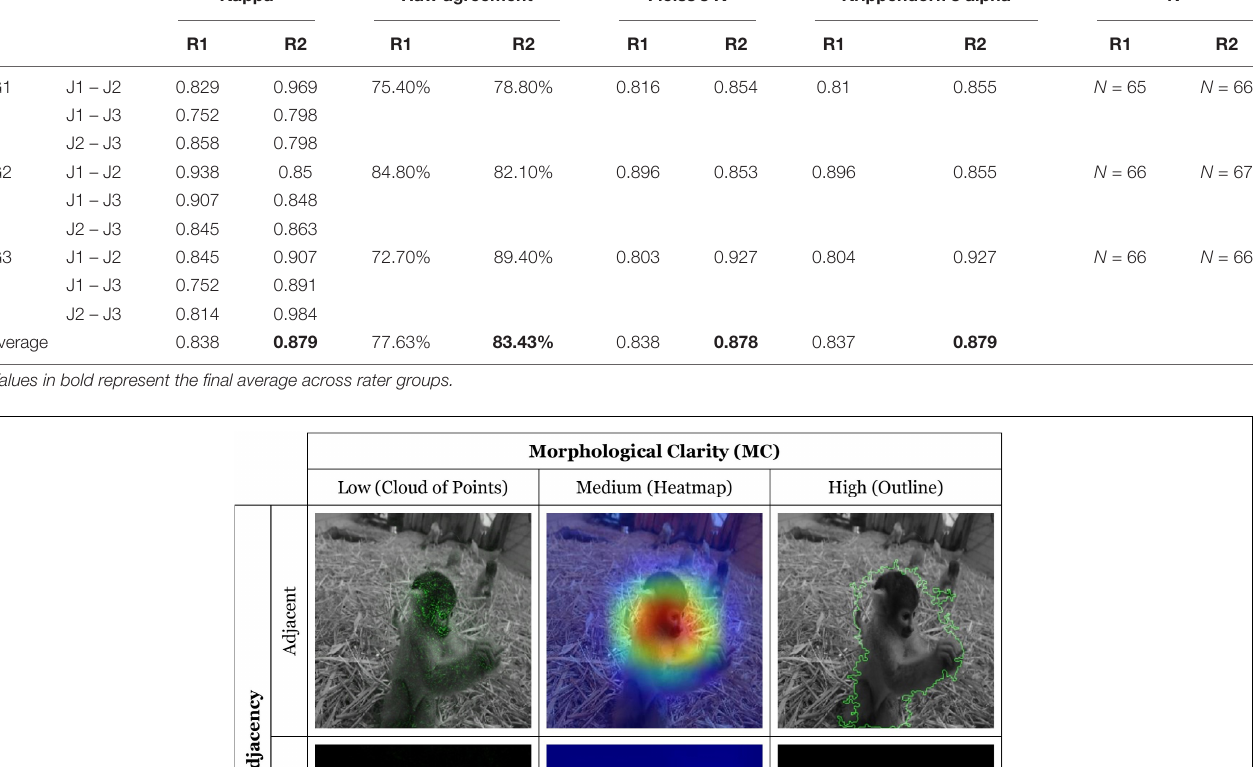
classification rate of 0.76, close enough to the algorithm’s